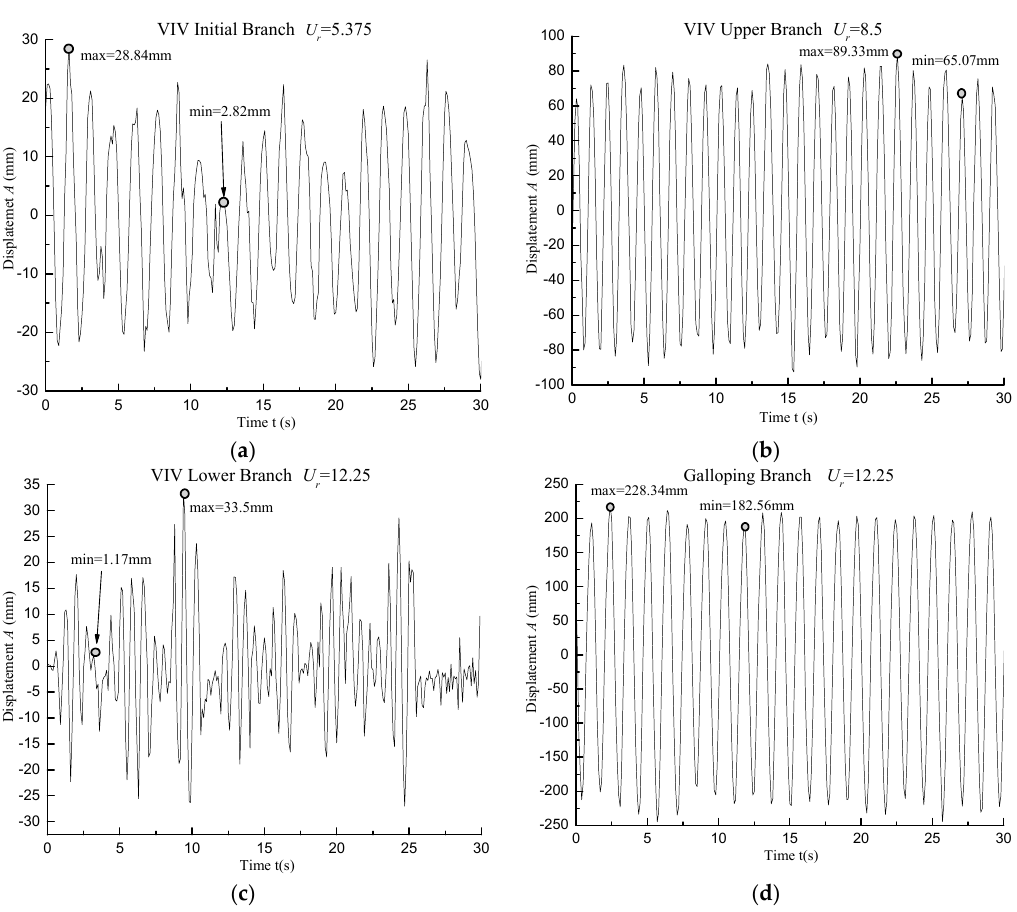
Figure 12. Typical flow-induced motion displacement time-history curves: ( a ) VIV initial branch; ( b ) VIV upper branch; ( c ) VIV lower branch; ( d ) galloping branch.